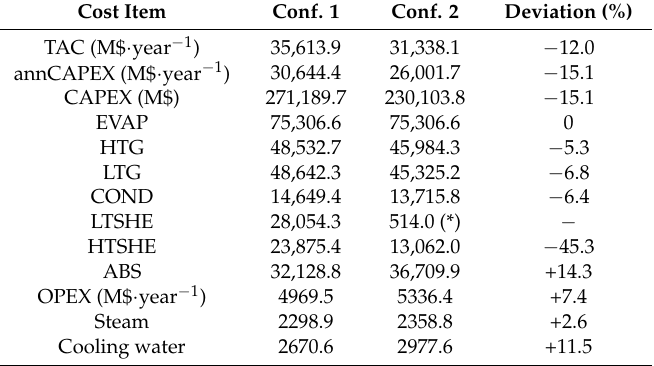
Table 4. Optimal cost values obtained for configurations Conf. 1 and Conf. 2 for a cooling capacity of 100 kW.